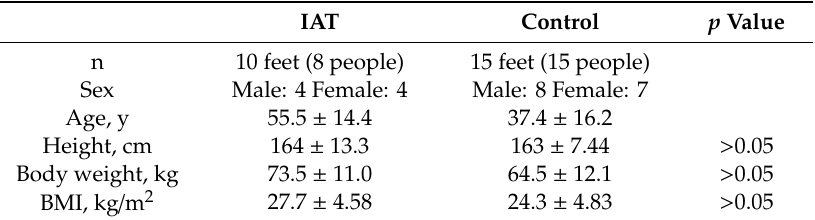
Table 1. Patient Characteristics.